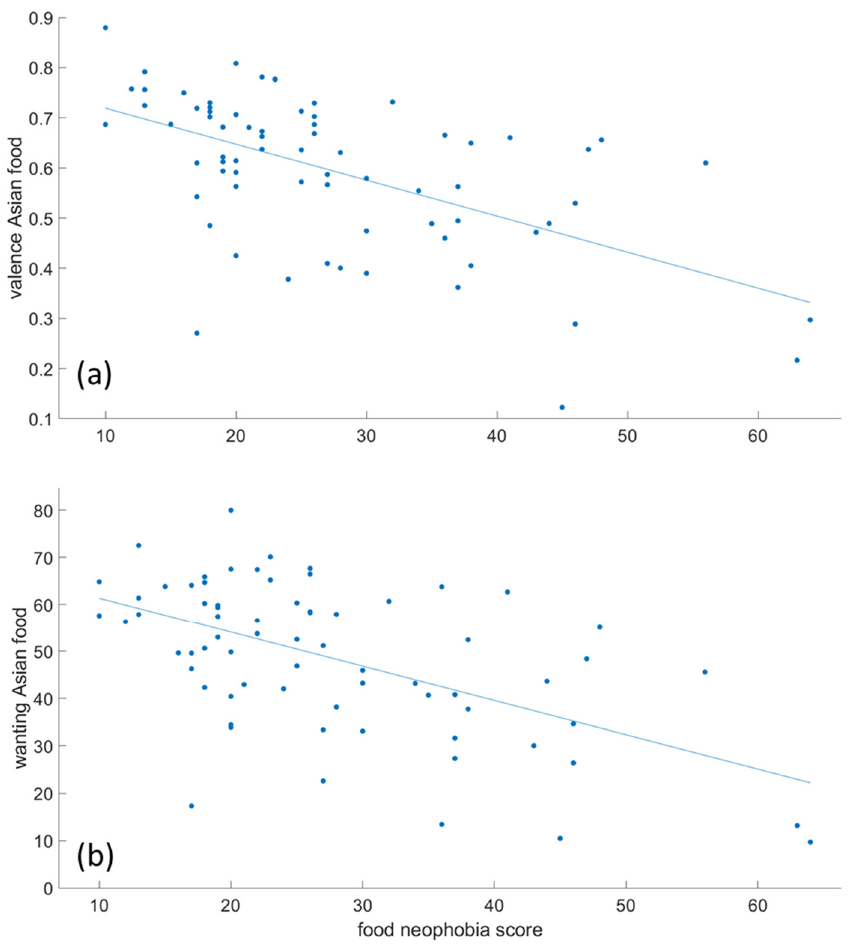
Figure 5. Correlation between food neophobia score and EmojiGrid valence ( a ) and wanting ( b ) for Asian food images. Each data point represents one participant.